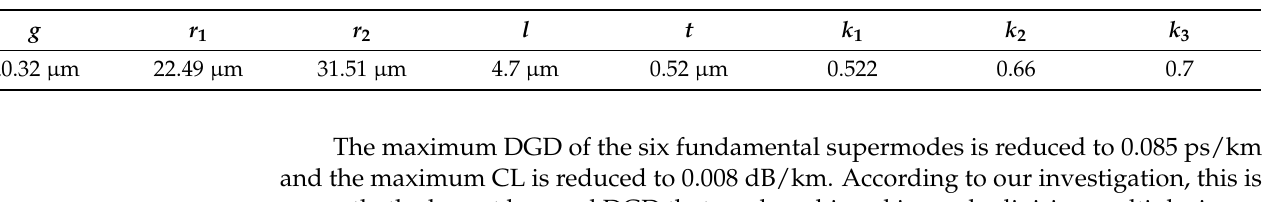
Table 2. Parameter settings when reaching the minimum of the maximum dispersion coefficient and differential group delay.